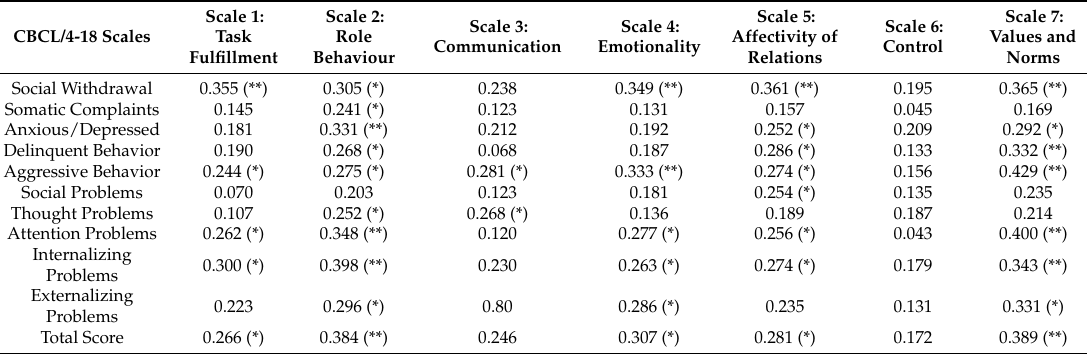
Table 5. Correlations of psychological problems of the children and family functioning. (Correlation analysis of CBCL/4-18 and FB-A Scales, Spearman´s rank correlation coefficient). CBCL/4-18